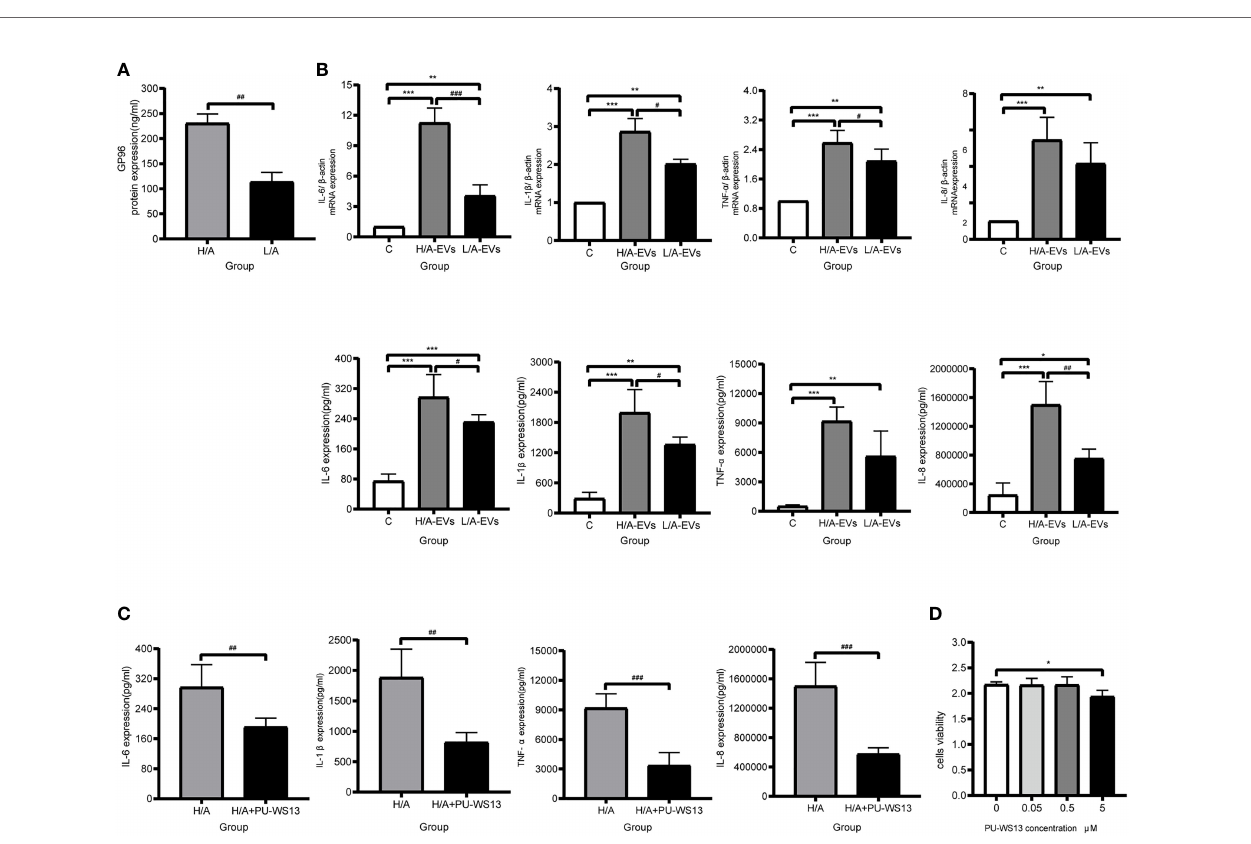
FIGURE 7 | PDE-EVs modulate in fl ammation via GP96. (A) Concentration of PDE-EVs-GP96 in the H/A and the L/A group was measured by ELISA ( n = 4 per group). (B) Relative mRNA or protein expressions of in fl ammatory factors IL-6, IL-1 b , TNF- a , IL-8 in macrophages were measured by real-time PCR or ELISA. In vitro , macrophages were incubated with H/A-PDE EVs (H/A-EVs, 2 mg/ml), L/A-PDE EVs (L/A- EVs, 2 mg/ml) ( n = 4). PBS was added in control group. (C) By using speci fi c inhibitor PU-WS13, inhibition of GP96 reduced the production of pro-in fl ammatory cytokines induced by PDE-EVs. Macrophages were stimulated with PDE- EVs isolated from the H/A group (2 mg/mL) for 24 hours alone or in combination with PU-WS13 (0.5 m M) before PDE-EVs for 1 hour (n = 4 per group). H/A group were treated with H/A-PDE EVs and DMSO. Culture supernatant was evaluated for secreted IL-6, IL-1 b , TNF- a and IL-8 by ELISA. (D) The viability of macrophages was determined by measuring the absorbance at 450nm through a microplate reader. Macrophages were stimulated with different concentration of PU-WS13 for 24 h (n = 6 per group). Data represent mean ± SEM of four independent experiments. Statistical analysis was performed with an unpaired Student ’ s t -test for two groups or one-way analysis of variance (ANOVA) for three groups. * p < 0.05, ** p < 0.01 and *** p < 0.001, compared with the C group or 0 group; # p < 0.05, ## p < 0.01 and ### p < 0.001 compared with the H/A group or H/A-EVs